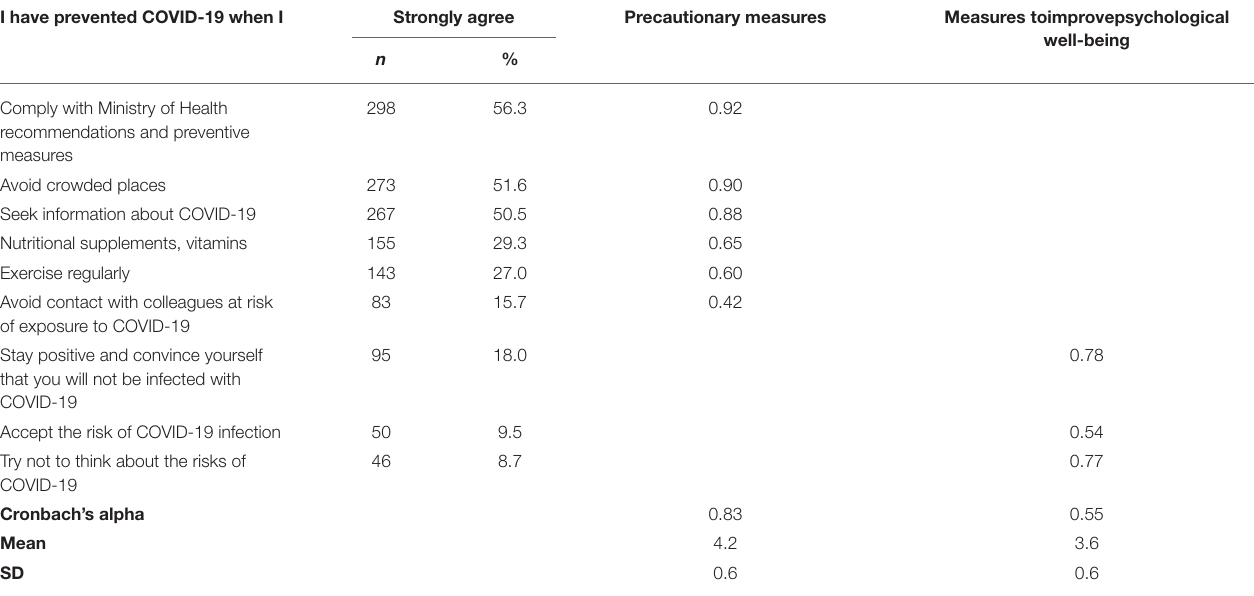
TABLE 3 | Measures taken to self-protect from